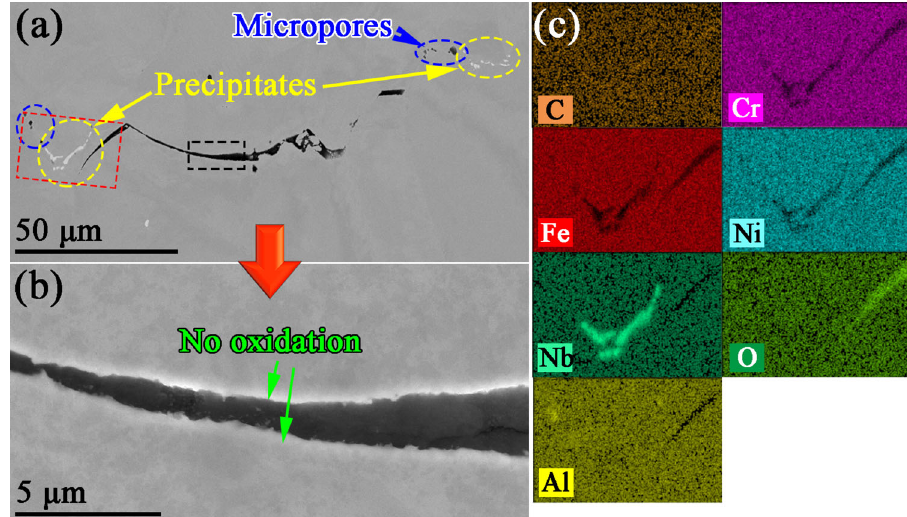
Fig. 10 Internal microcracks in the dark frame of Fig. 9b (A2 sample, 3.5Al – 0.6Nb). a , b BSE images, c EDS in the red frame of ( a ).